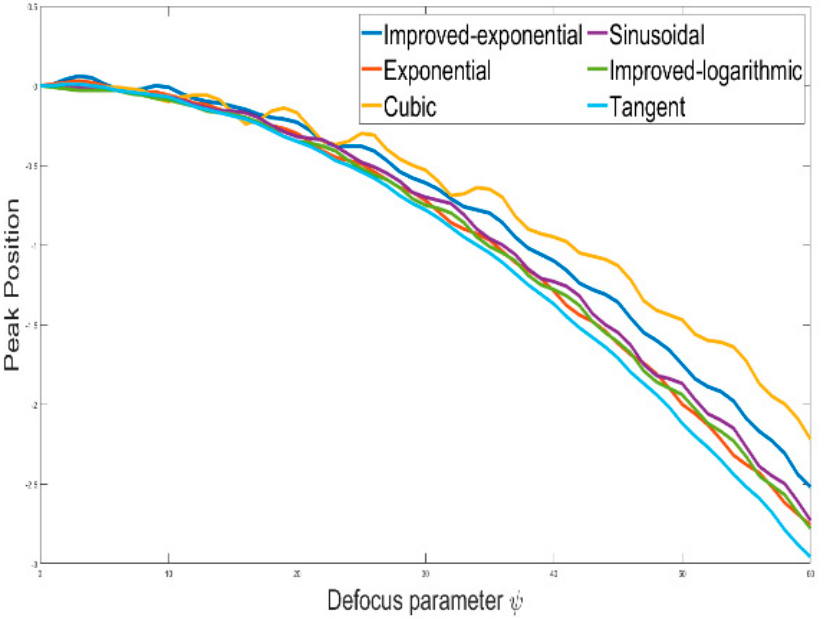
Figure 9. Peak position difference variation with defocus of MTF of six kinds of phase masks. Finally, we simulated the imaging process to evaluate the performance of phase masks.